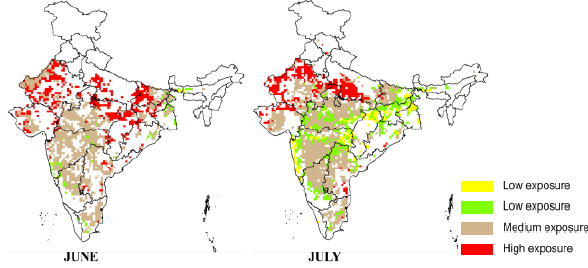
Figure 8: Exposure maps having at least 10 years of